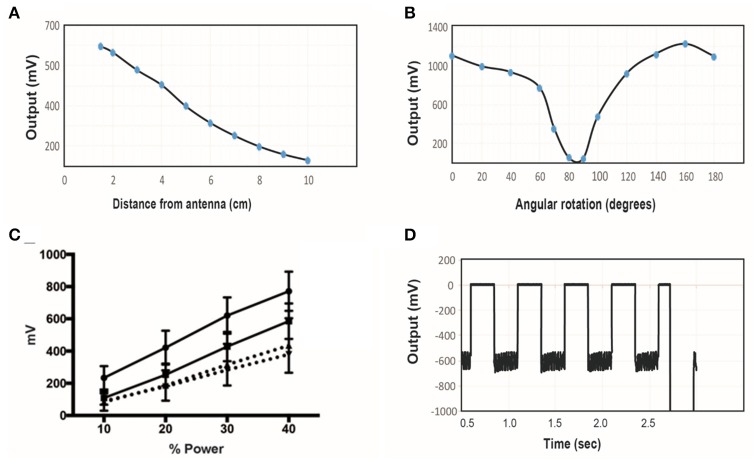
(A) The induced voltage in the electroparticle as a function of distance from the transmitter for an input power of 40%. (B) Induced voltage at 0 cm distance measured as a function of rotation angle relative to the plane of the transmitter. (C) Electroparticle output as a function of applied magnetic field at a distance of 5 cm for four different devices. (D) Induced voltage during square-wave excitation during the waveforms used for motor excitation: a train of 1 ms RF-pulses was delivered at 50 Hz for 250 ms, and this was repeated at 2 Hz. The transmit frequency was 10.9 MHz and the load connected across the two disc electrodes was a 10 kΩ resistor in all cases.